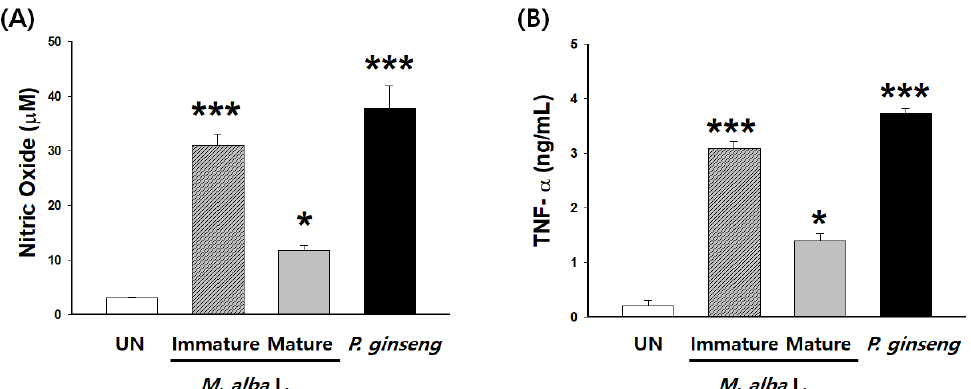
Figure 3. Comparison of murine peritoneal macrophage (RAW 264.7, ATCC ® TIB-71™) activity in immature and mature M. alba L. fruits and Korean 6-year root red ginseng (KCG, daejeon, Korea). Macrophages were treated with extracts from immature and mature M. alba fruits or Korean 6-year root red ginseng extract (100 μg/mL) for 24 h. ( A ) Nitric oxide and ( B ) TNF-α production in supernatants were measured using ELISA. Data are expressed as mean ±SD values. All the data were confirmed by technical replicate 3 times. Significant differences were compared using repeated measures ANOVA followed by the Newman–Keuls multiple range test. Statistical significance was defined as * p < 0.05, *** p < 0.001. All statistical analyses were performed using GraphPad Software. Inc. (San Diego, CA, USA). 5. Immune Stimulation by M. alba Bioactive Phytochemicals In M. alba, polysaccharides and alkaloids are thought to be the immune-stimulating components and they are more prevalent in the fruits than in any other parts of the plant.